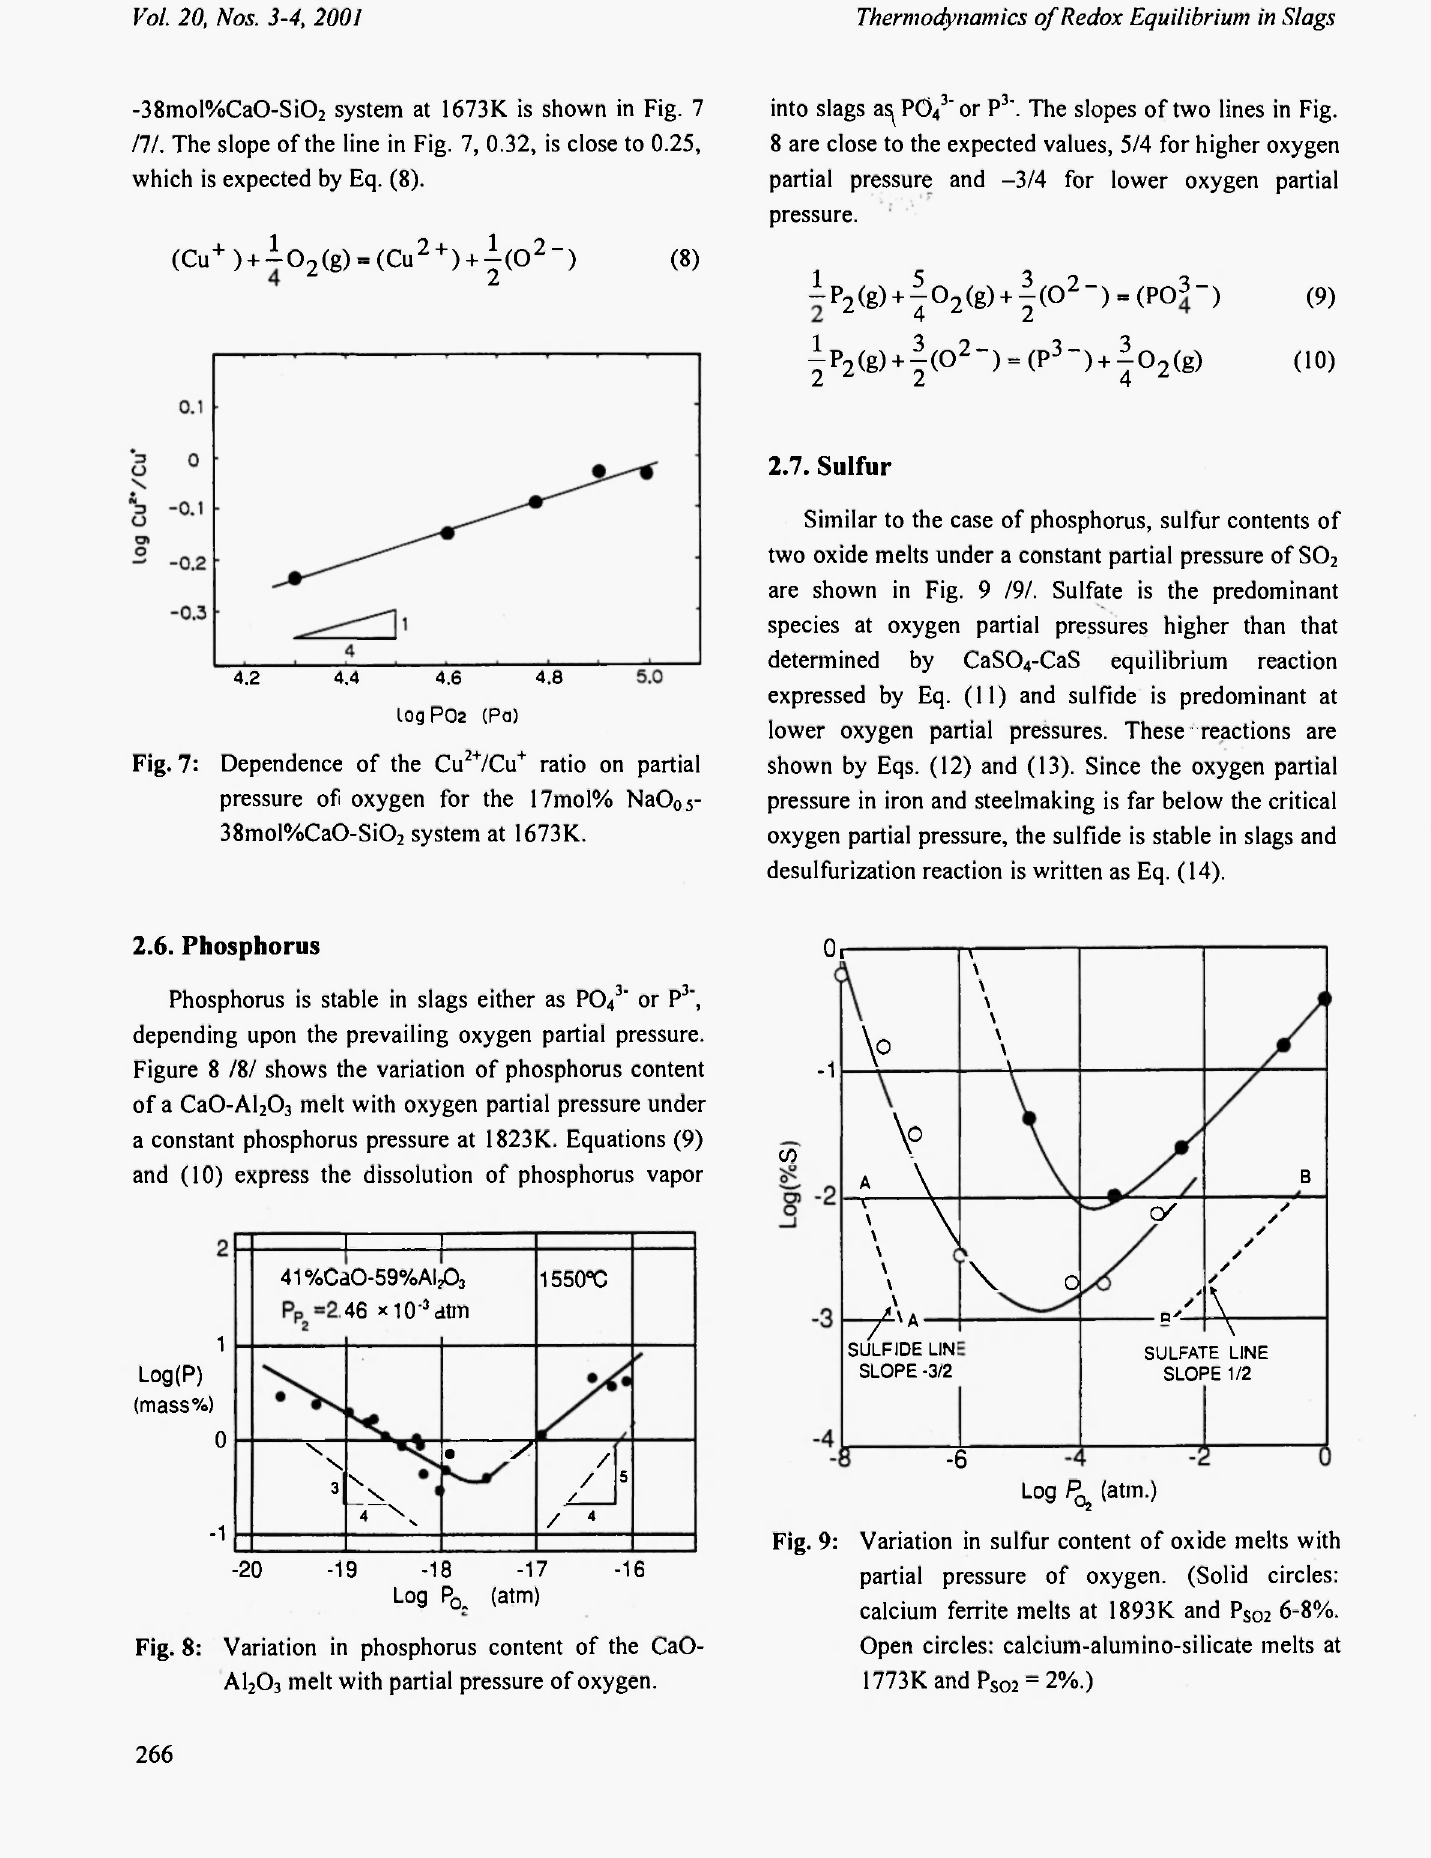
Fig. 8: Variation in phosphorus content of the CaO- A1 2 0 3 melt with partial pressure of oxygen.